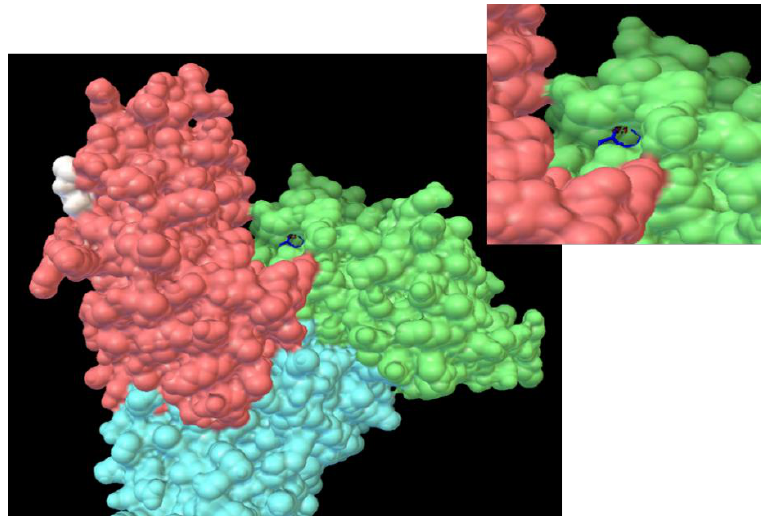
Figure 13. Binding site on domain split for prothioconazole/human serum albumin (PTC/HSA); prothioconazole/bovine serum albumin (PTC/BSA) interaction.